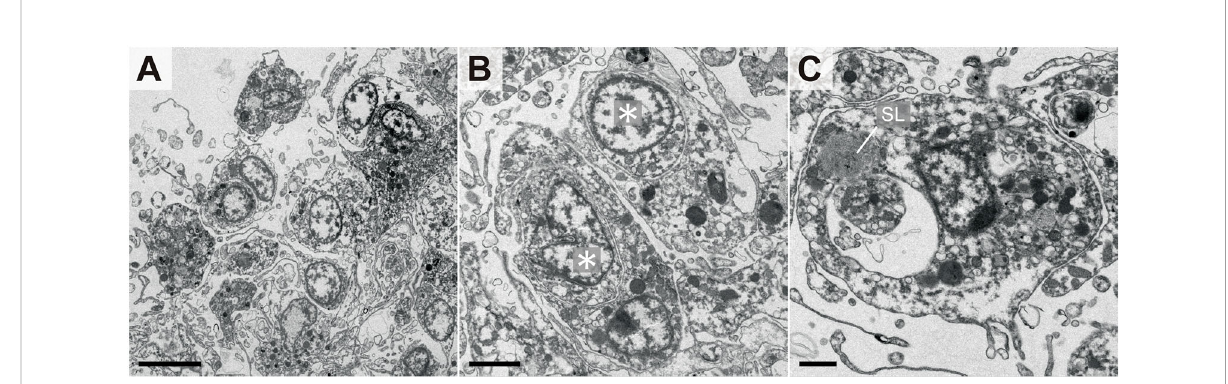
FIGURE 3 Internal morphology of coelomocyte aggregates in response to allogeneic coelomocytes. (A) Outer edge of aggregate. (B) Coelomocytes that phagocytosed other coelomocytes. Asterisks indicate the nuclei of phagocytosed coelomocytes. (C) Coelomocyte during digestion of the